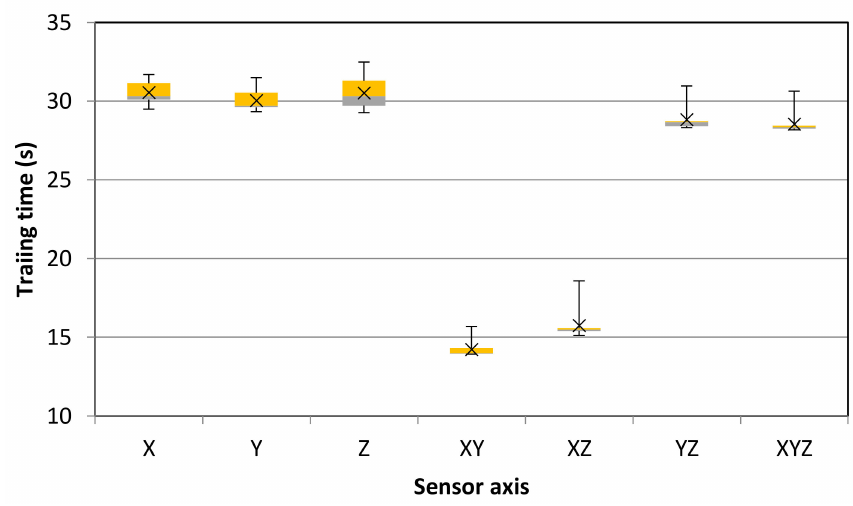
Figure 25. Box plot of ‘training time’ for all sensor axis of the dynamometer.